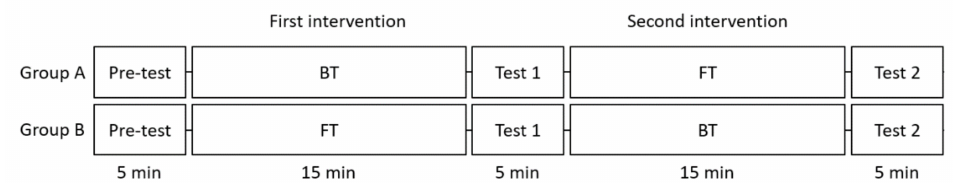
Figure 3. Data collection process. Groups A and B underwent two different interventions in a different order. FT intervention: the line-magnets were positioned with N poles proximal and S poles distal, in which the N pole of the line-magnet was attached to the direction of the starting point of the heart meridian [8]. BT intervention: the N pole of line-magnet was attached to the direction of the end point of the heart